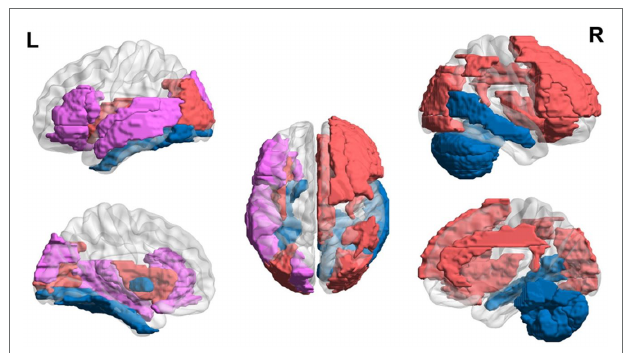
FIGURE 2 | Neural circuit dysfunction related to reading circuits in children (ages 6–12) with dyslexia. Decreased activation in left superior temporal gyrus (Kita et al., 2013; Saralegui et al., 2014), bilateral middle temporal gyrus (Saralegui et al., 2014), left fusiform gyrus (Desroches et al., 2010; Saralegui et al., 2014), left globus pallidus (Kita et al., 2013), left inferior frontal gyrus (Liu et al., 2012), right cerebellum (van Ermingen-Marbach et al., 2013), and left superior occipital gyrus (Backes et al., 2002; Shaywitz et al., 2002) and increased activation in the right superior frontal gyrus (Horowitz-Kraus et al., 2016), right middle frontal gyrus (Horowitz-Kraus et al., 2016), bilateral insula (Rimrodt et al., 2008), left superior temporal gyrus (Rimrodt et al., 2008), left middle temporal gyrus (Rimrodt et al., 2008), right cingulum (Rimrodt et al., 2008), right inferior parietal lobule (Rimrodt et al., 2008), bilateral occipital gyrus (Seki et al., 2001), and bilateral inferior frontal gyrus (Seki et al., 2001; Georgiewa et al., 2002; Shaywitz et al., 2002), related to EF in children ages 6–12 at risk for dyslexia. Red represents areas of hyperactivity, blue areas of hypoactivity, and purple areas where papers have reported hyperactivity and hypoactivity. Data are presented in sagittal and axial views in the left and right hemispheres (L = left and R = right) over a glass brain. Regions were defined based on AAL atlas (Tzourio-Mazoyer et al., 2002). Image created using the BrainNet Viewer (Xia et al.,